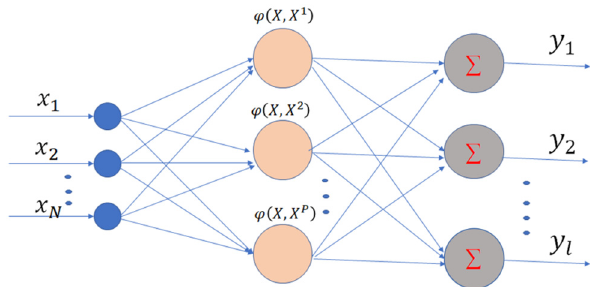
Figure 1: RBF neural network